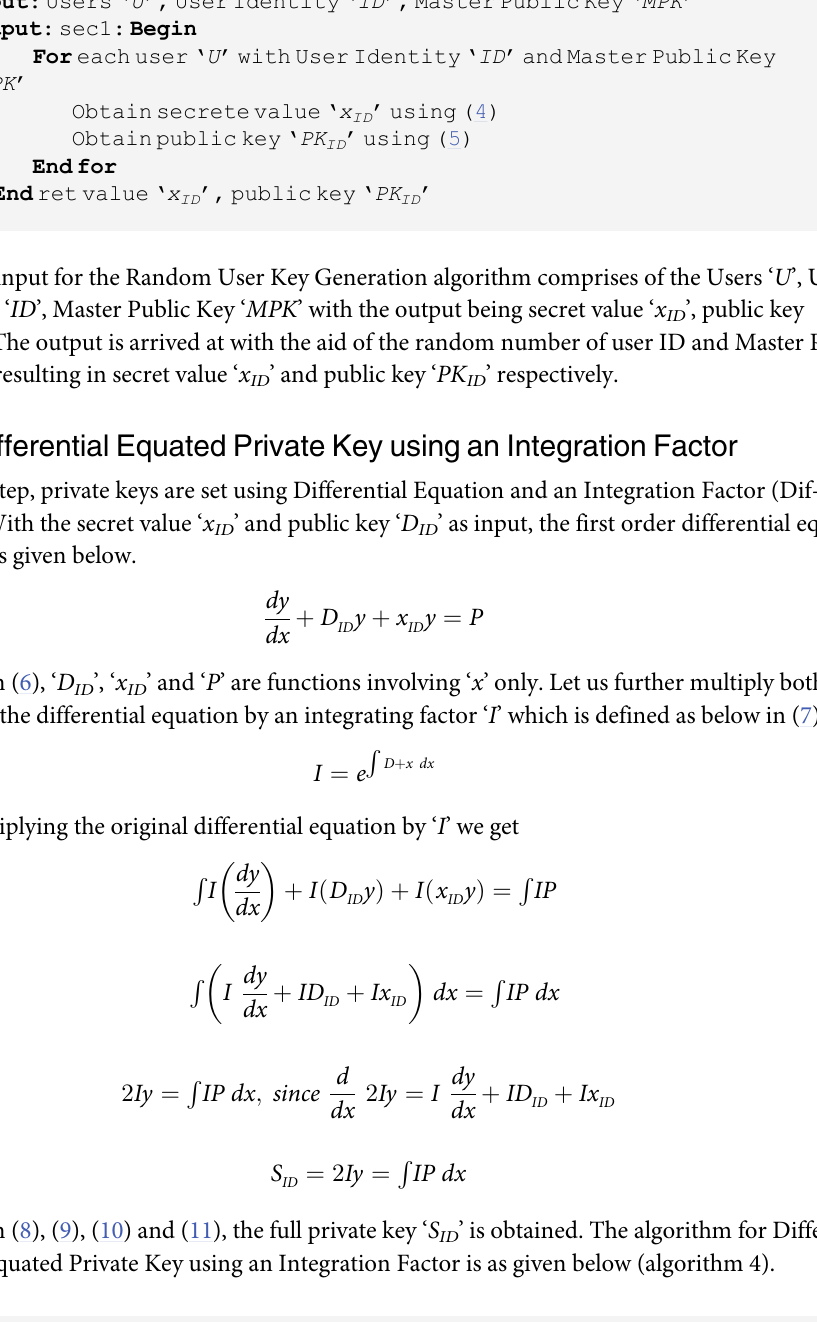
Algorithm4. PrivateKey using